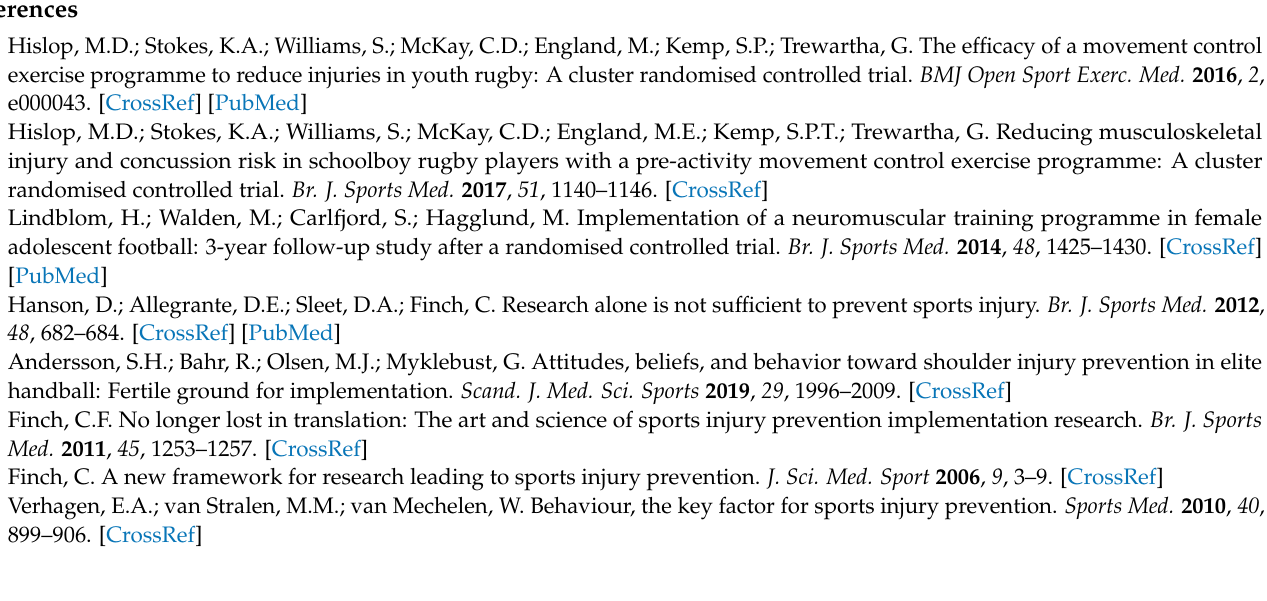
Table S2: Baseline participant demographics, Table S3: Coach perceptions towards rugby injury risk and prevention at baseline and